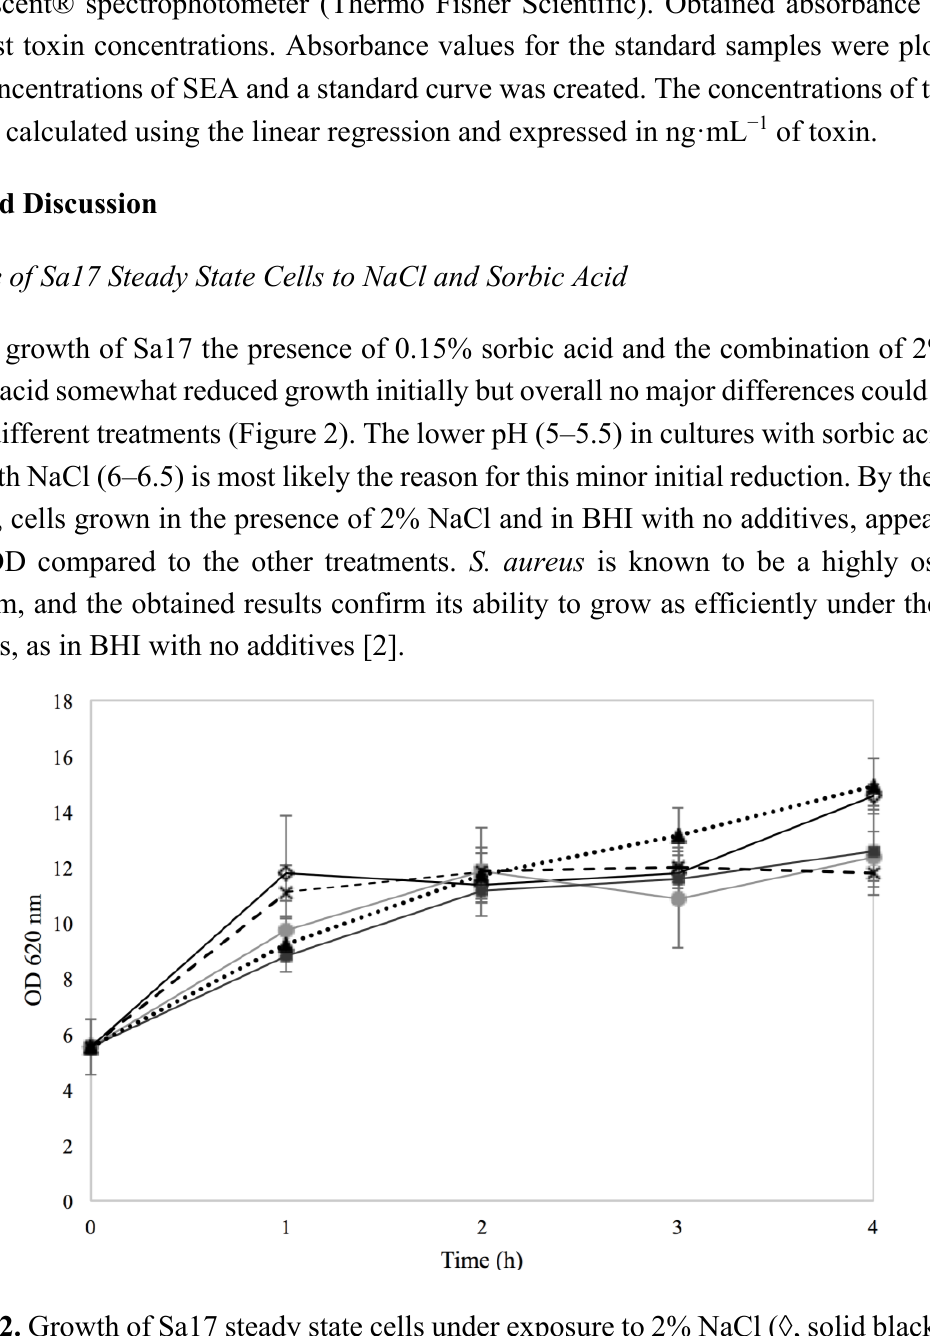
Figure 2. Growth of Sa17 steady state cells under exposure to 2% NaCl (◊, solid black line), 0.15% sorbic acid (●, solid light grey line), 2% NaCl + 0.15% sorbic acid (■, solid dark grey line) in batch cultivation conditions. Controls with MMC ( × , dashed line) and BHI with no additives (▲, dotted line) were included. Results are obtained from two independent experiments. The Y axis represents OD measured at 620 nm and the X axis the time in hours. Time point 0 h represents the moment when the steady state cells (OD 5.5) were harvested, transferred into flasks and subjected to the various